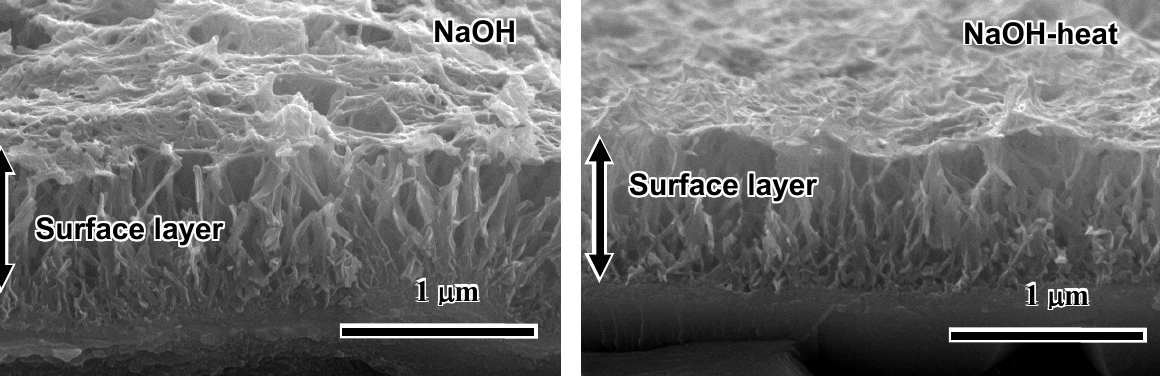
Figure 2. SEM photographs of cross sections of surfaces of Ti metals subjected to NaOH and heat treatments.